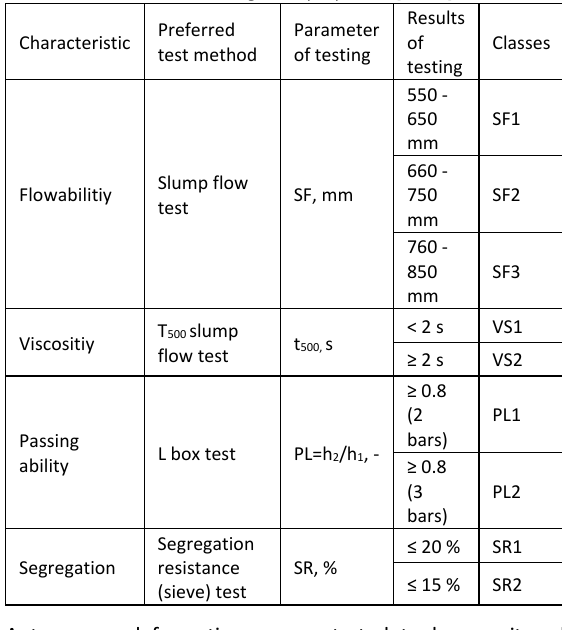
Table 4. SCC criteria for testing fresh properties